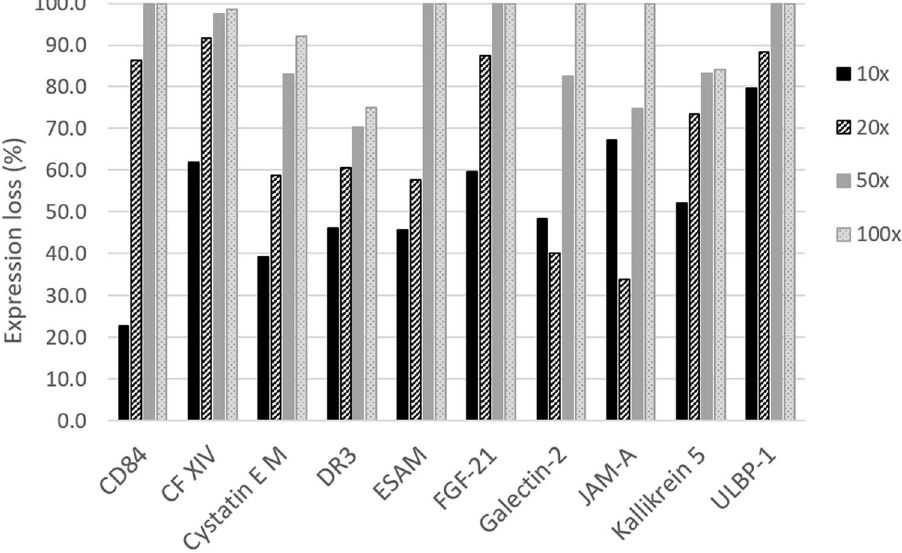
Figure 5. Optimization of sample dilution of DBS eluates for use on a quantitative immunoassay platform. 5 different eluate dilutions: 5 ×, 10 ×, 20 ×, 50 × and 100 × were used to quantitatively assess 40 proteins. The % expression loss compared with the 5 × dilution is shown for a subset of 10 proteins.